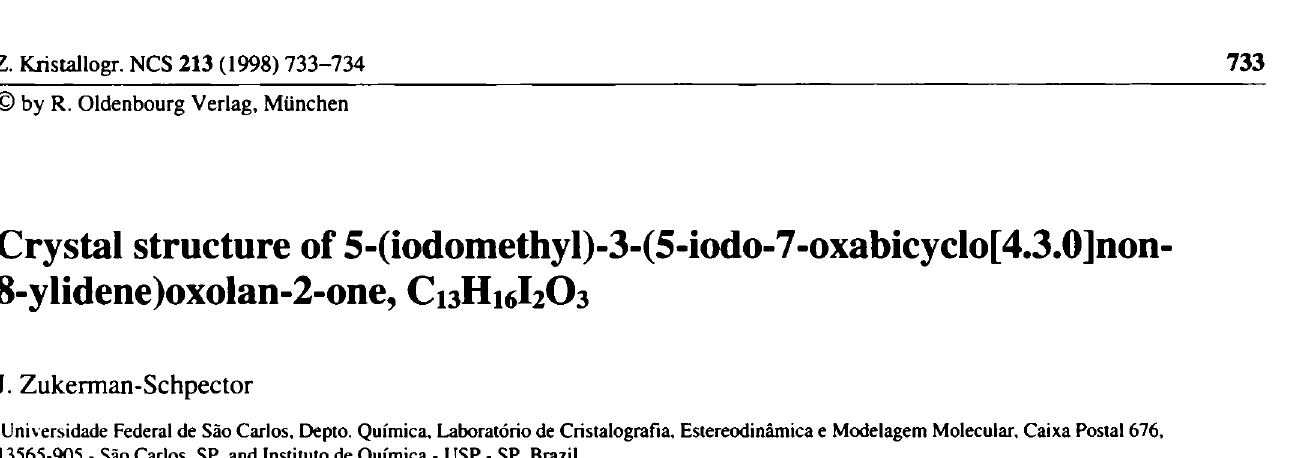
Table 1. Parameters used for the X-ray data collection Crystal: